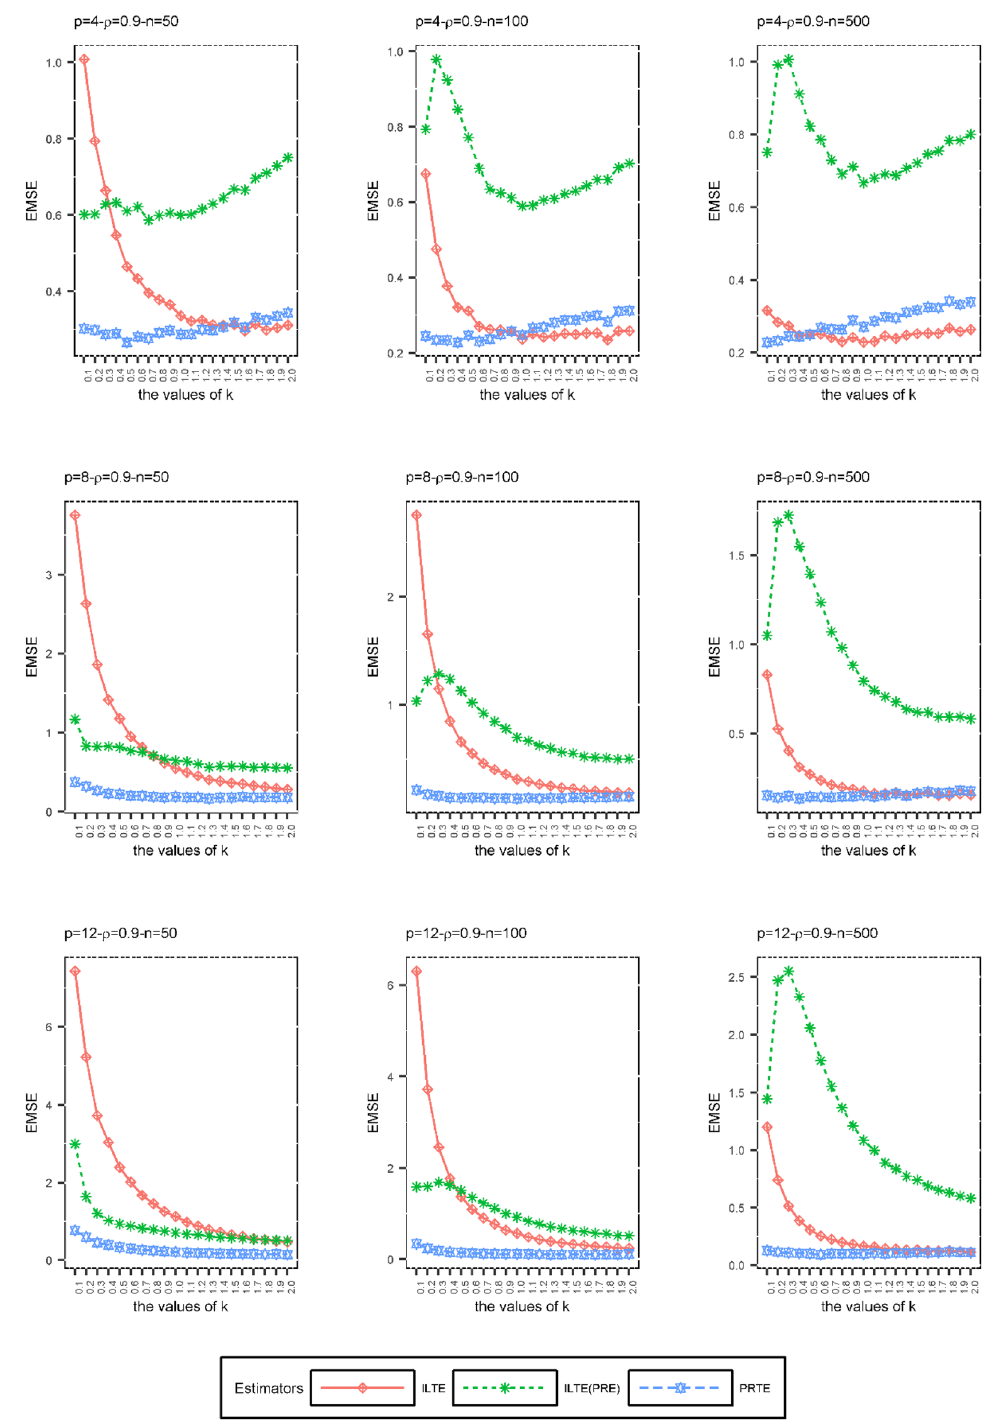
Figure 1. The EMSE values of ILTE, ILTE(PRE), PRTE as a function of k values where ρ = 0.9